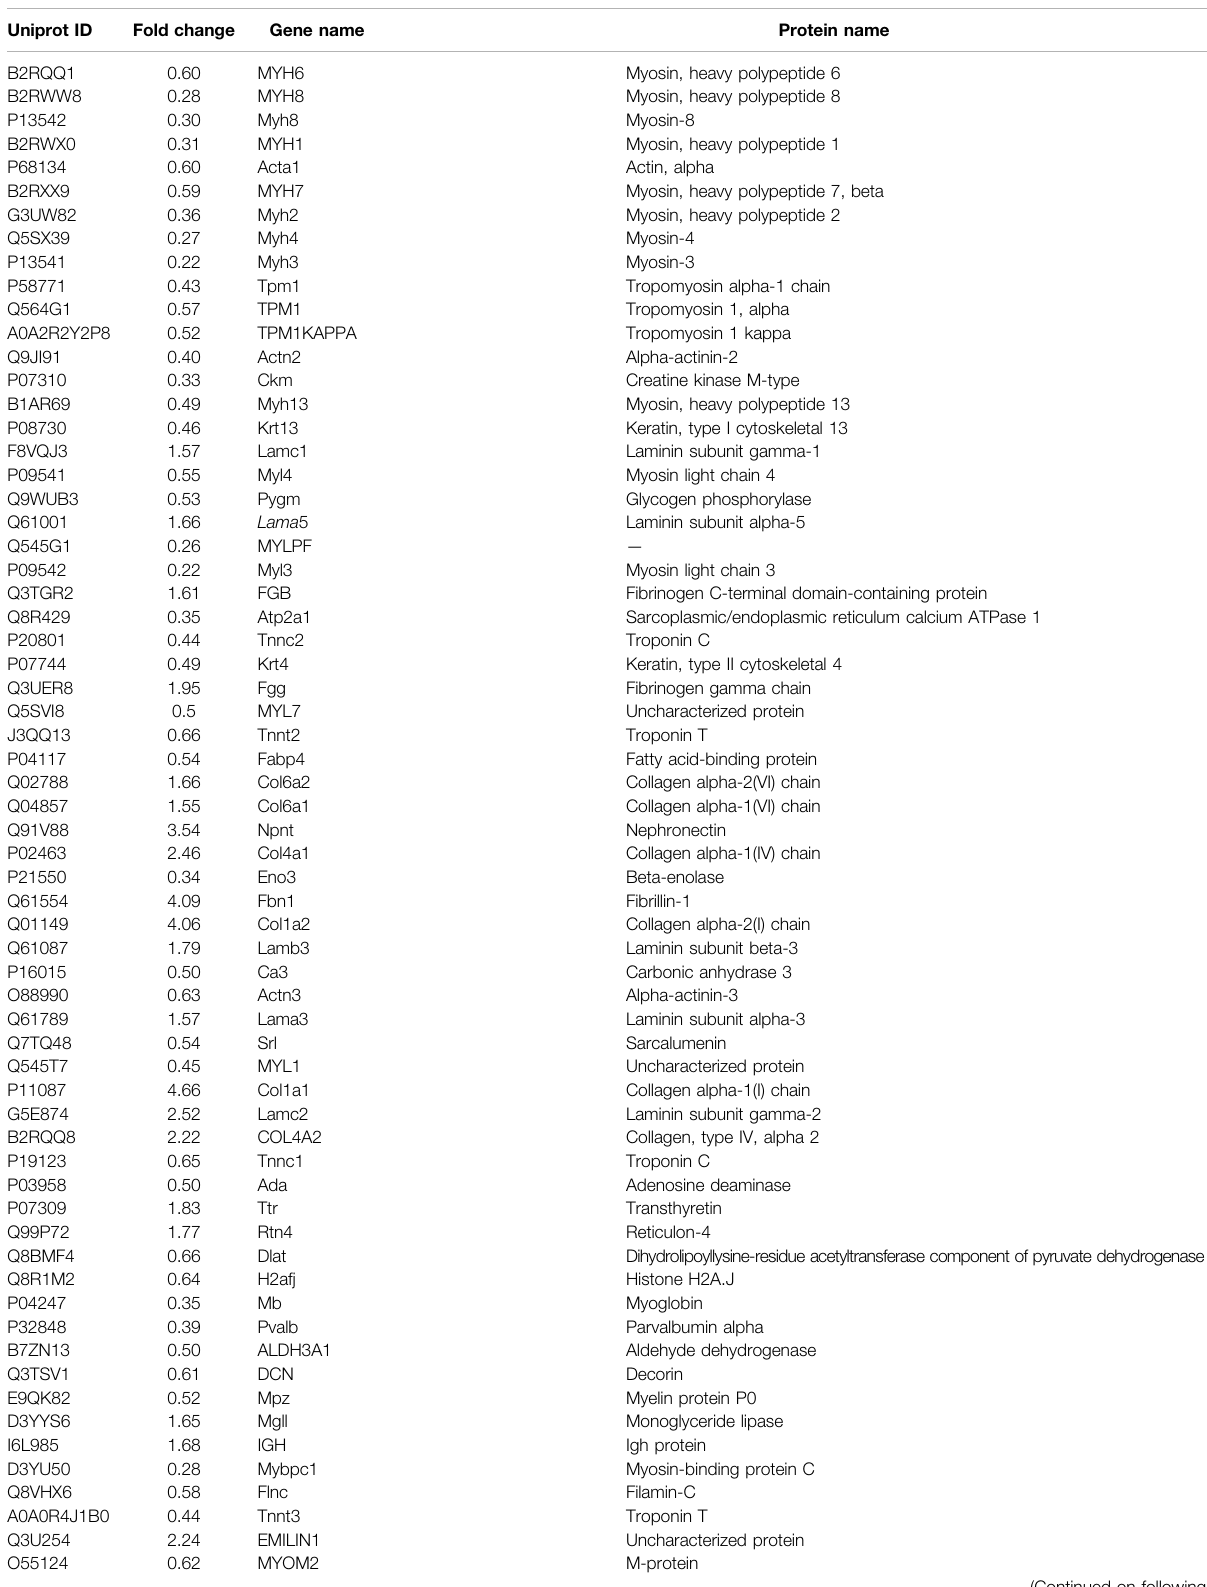
TABLE 4 | The DAPs of lung in the model group compared with the control group. Uniprot